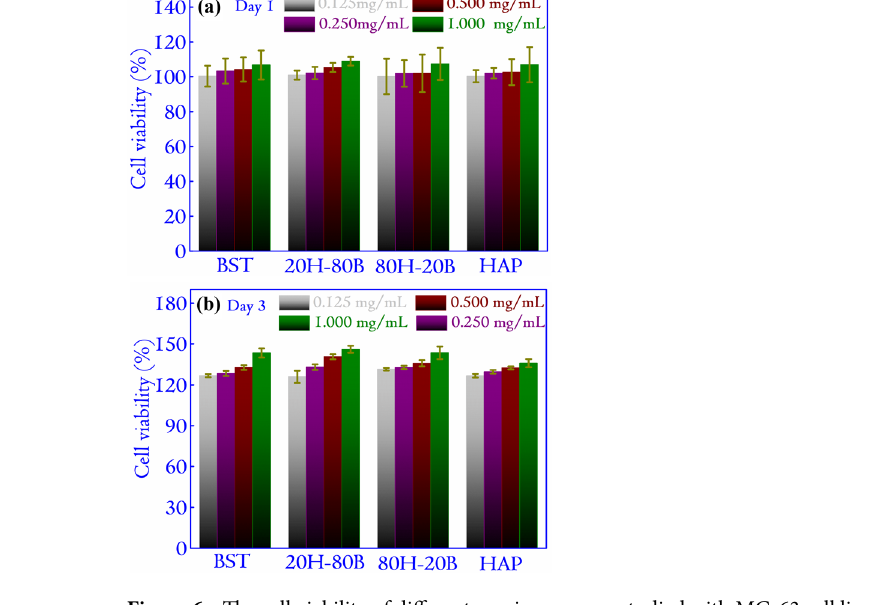
Figure 6. The cell viability of different specimens were studied with MG-63 cell lines for Day 1 and Day 3. All the specimens showed excellent viability amounting to values greater than 100% for all the concentrations. The higher cell viability of 20H–80B is mostly related to the presence of Ba and Sr ions, which have favored the proliferation of cells over the specimens.